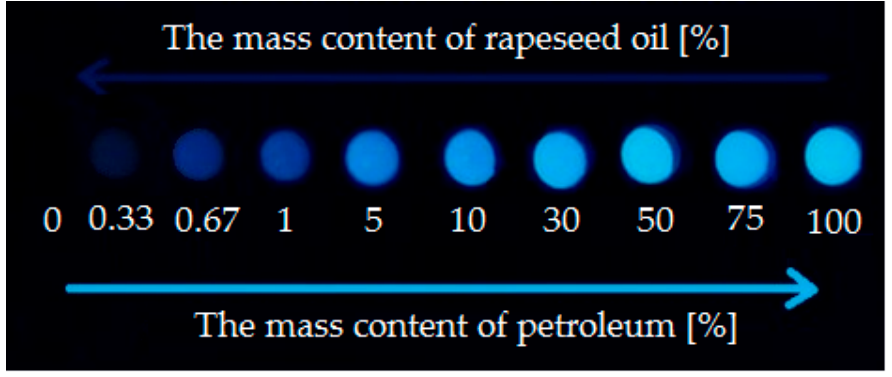
Figure 3. Fluorescence of mixtures of vegetable and petroleum oil in various proportions (by mass) illuminated with a UV LED lamp, λ = 365 nm.